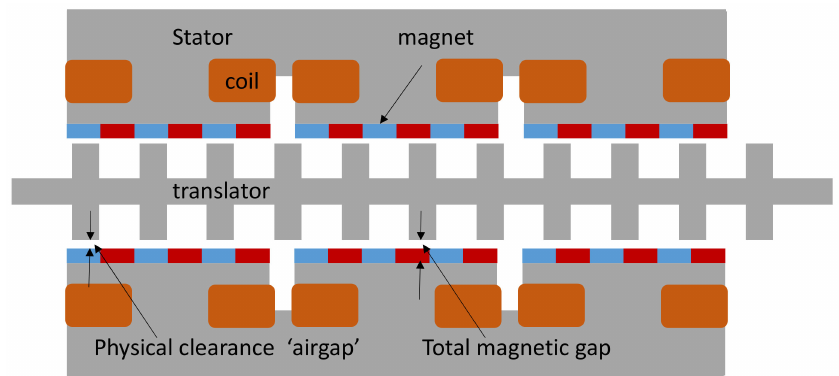
Figure 3. A three-phase double-sided linear vernier hybrid machine. Magnet colour indicates the direction of magnetisation as being either up or down the page. Stator magnets are surface mounted.